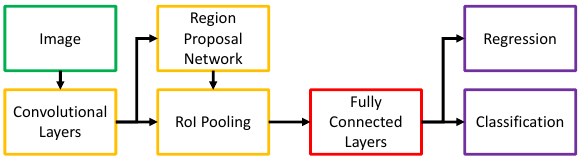
Figure 2. Structural overview of the Faster R-CNN. Based on the deep VGG-16 network, it is composed of 13 convolutional layers and two fully connected layers. The object proposals are classi- fied by a softmax classifier and their coordinates are computed by the regression